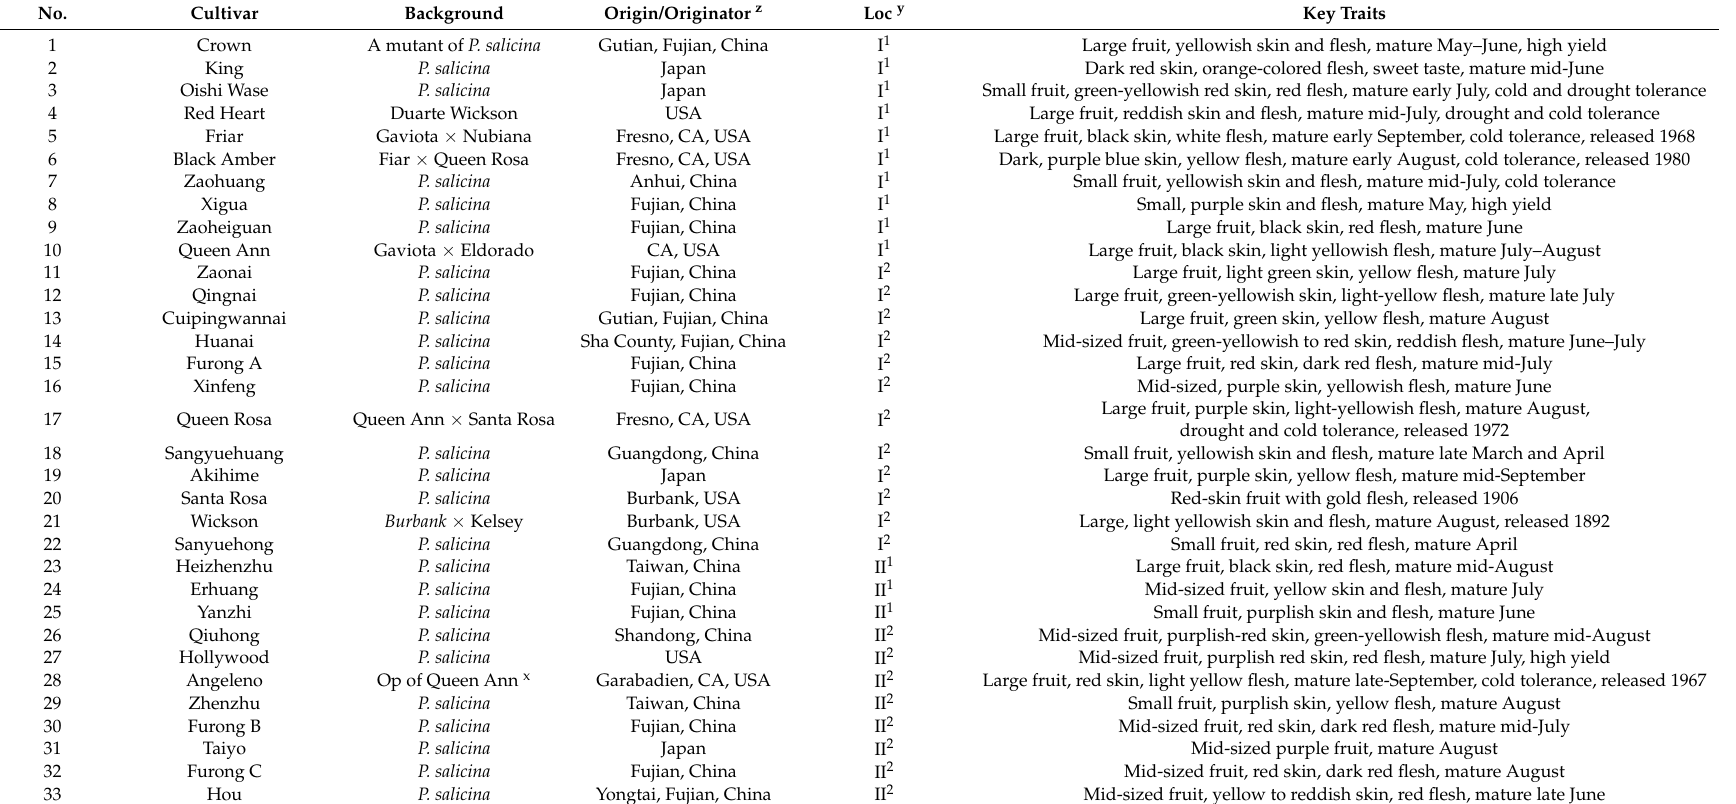
Table 1. Sources of ISSR analyzed Prunus salicina varieties cultivated in Fujian province,